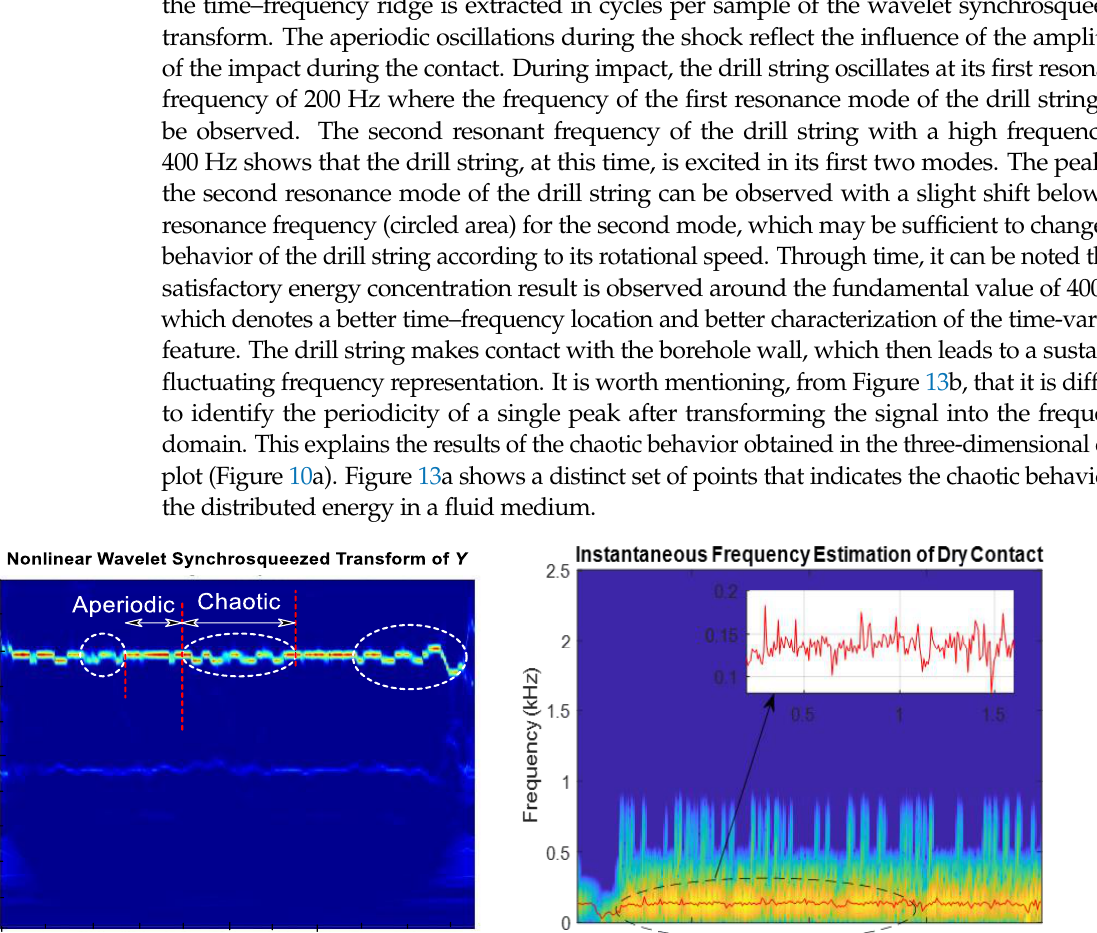
( b ) Figure 14. Friction/fluid-NWSST representation of the rotor-casing rubbing signal in an inviscid fluid. ( a ) Time-frequency ridges from NWSST; ( b ) Estimated IF amplitude spectrum of the signal. Observation 4: The useful information in the harmonic distribution is observed in Figure 12 at some specific disturbed periods illustrated by the high peak’s shape disturb- ance throughout the signal, while in the spectrum bands, the diminution of the impact amplitude is prominent. It can also be seen from Figure 12 that there are good approxi- mations of the signal’s instantaneous frequency , which oscillates periodically and differs from the IF of the imbalanced drilling/casing system with the eliminated hydrodynamic forces. The damping imposed by the presence of fluid makes it possible to obtain a good prediction of the behavior of the drill string subjected to an impact. Adding a dissipative